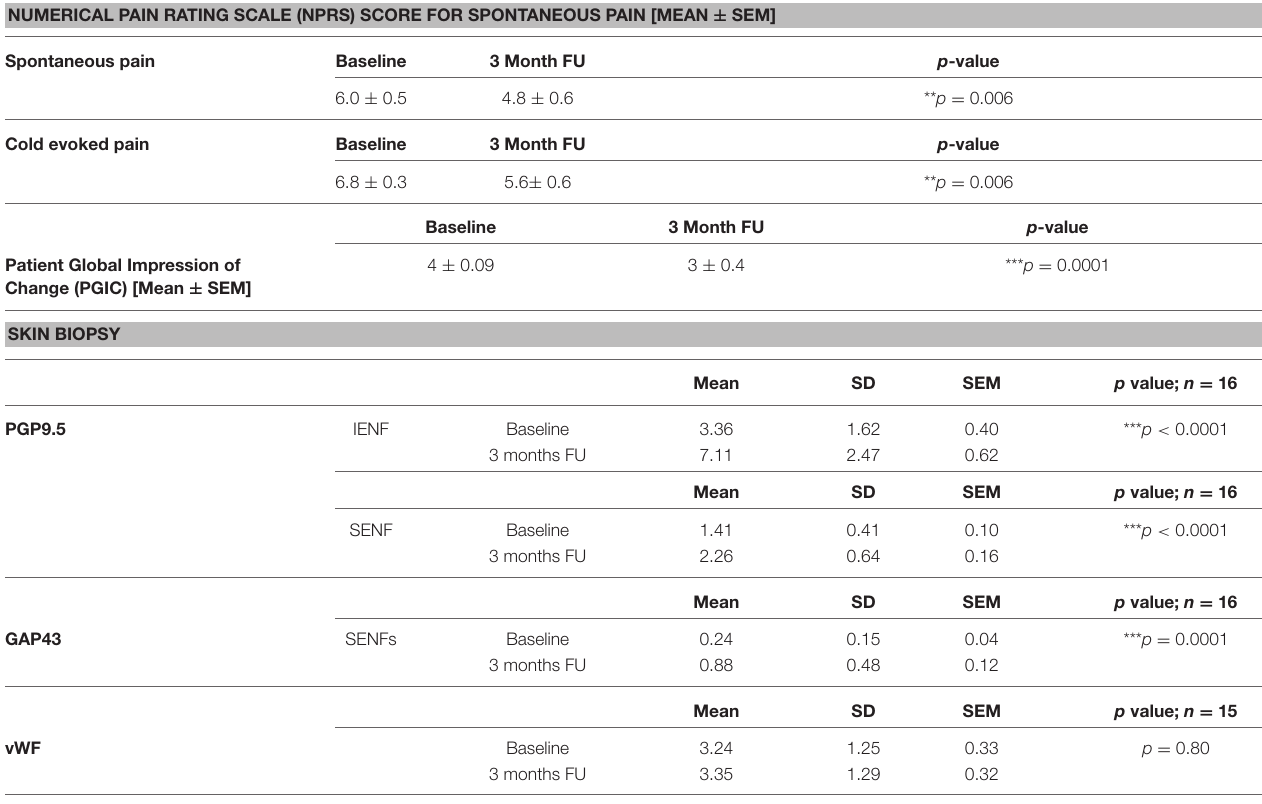
TABLE 2 | Results at baseline and at 3 month follow-up for participants with NFCI treated with Capsaicin 8% patch for spontaneous or cold-evoked pain (NPRS; paired t -test), Patient Global Impression of Change (PGIC; paired t -test, baseline PGIC was change from screening to baseline visit), and the skin biopsies. NUMERICAL PAIN RATING SCALE (NPRS) SCORE FOR SPONTANEOUS PAIN [MEAN ± SEM] Spontaneous